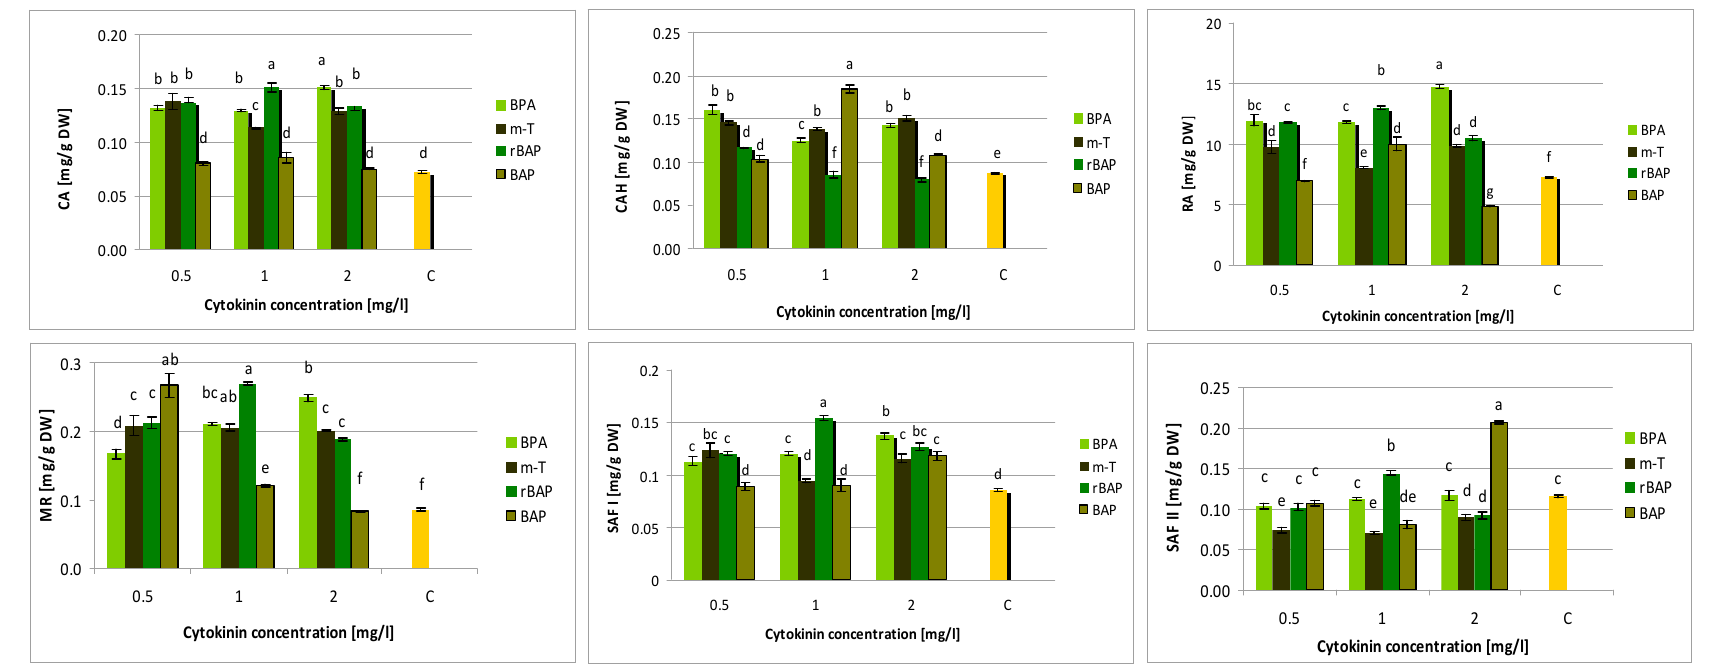
Figure 4. Effect of cytokinin type and concentration on polyphenolic acid content (mg/g DW) in shoot culture of S. viridis. CA—caffeic acid, CAH—caffeic acid hexoside, RA—rosmarinic acid, MR—methyl rosmarinate, SAF I—salvianolic acid F (I), SAF II—salvianolic acid F (II), C—control, shoots cultivated on MS medium only with auxin (0.1 mg/L IAA). The values represent the mean ± standard error of three independent experiments. Means marked with the same letter were not significantly different according to the one-way ANOVA test, followed by the post hoc Tukey’s test for multiple comparison ( p ≤ 0.05).